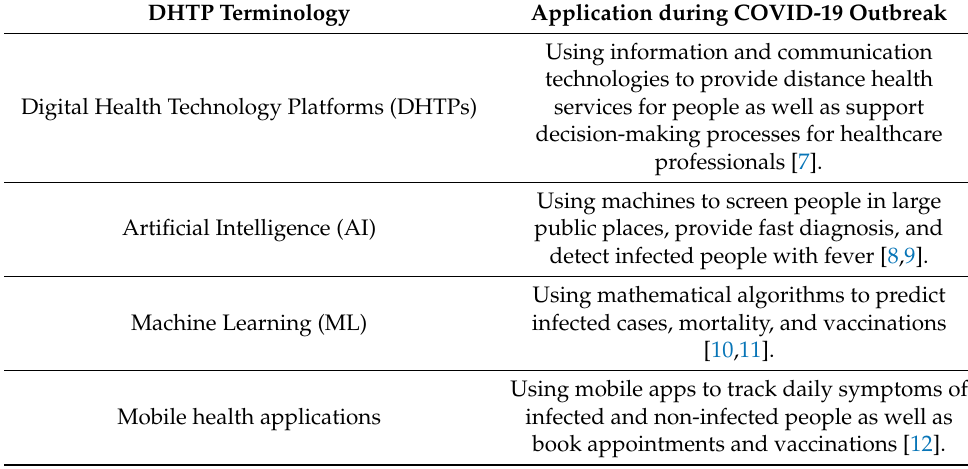
Table 1. The application of digital health technology platforms (DHTPs) during the COVID-19 pandemic. DHTP Terminology Application during COVID-19 Outbreak Using information and communication technologies to provide distance health services for people as well as support Digital Health Technology Platforms (DHTPs) decision-making processes for healthcare professionals [7]. Using machines to screen people in large Artificial Intelligence (AI) public places, provide fast diagnosis, and detect infected people with fever [8,9]. Using mathematical algorithms to predict Machine Learning (ML) infected cases, mortality, and vaccinations [10,11]. Using mobile apps to track daily symptoms of Mobile health applications infected and non-infected people as well as book appointments and vaccinations